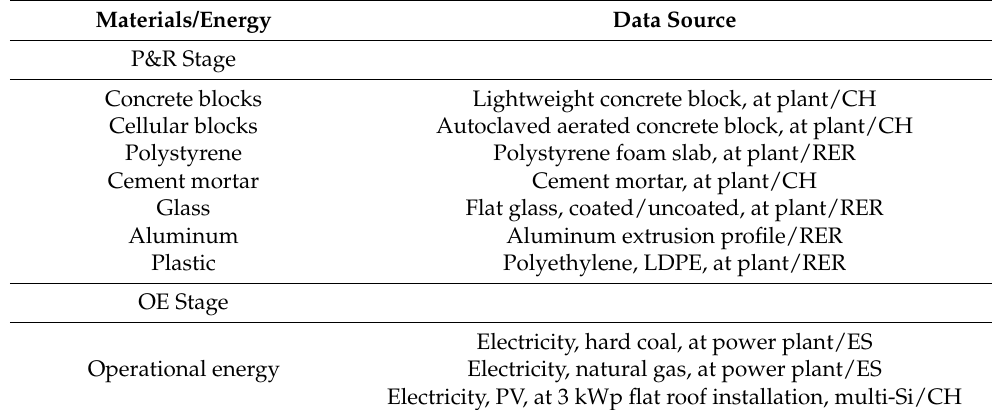
Table 3. Production and replacement (P&R) and operational energy (OE) stages: data input from